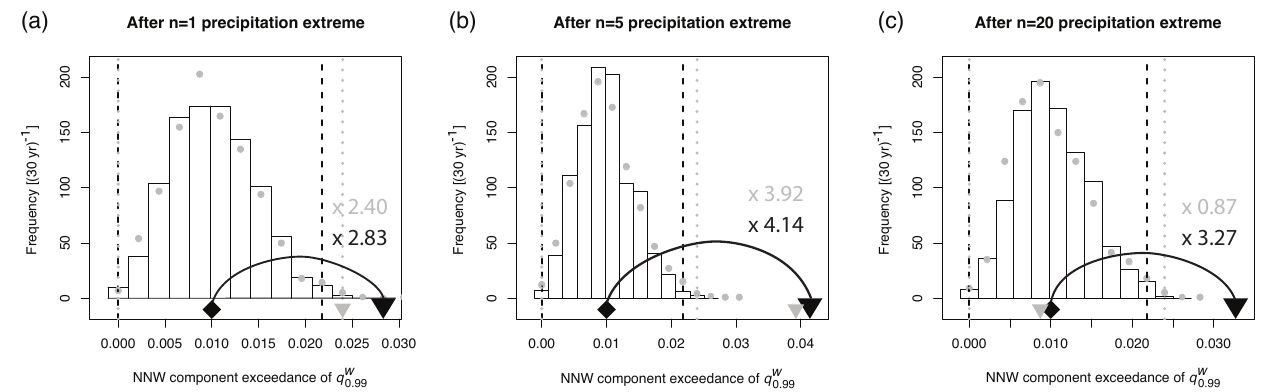
Fig. 4. Exceedance of the climatological q w for days immediately following extreme n -day precipitation sums (marked on the horizontal 0 . 99 axis by a black triangle for 1950–1980, and grey triangle for 2070–2100) and, for comparison, for the 1000 random samples (see Sect. 2.3 for details on construction of the samples) presented as a histogram (bars for 1950–1980, dots for 2070–2100). The vertical lines enclose 99% of the 1000 samples (black dashed for 1950–1980, grey dotted for 2070–2100). The climatological exceedance, 0.01, which is the expected ) and P(r ∗ n ) are independent, is marked by a black diamond. The multiplication factors between the expected exceedance if assuming P(w ∗ 1 exceedance and the black and grey triangles are written in the panels in black and grey, respectively.